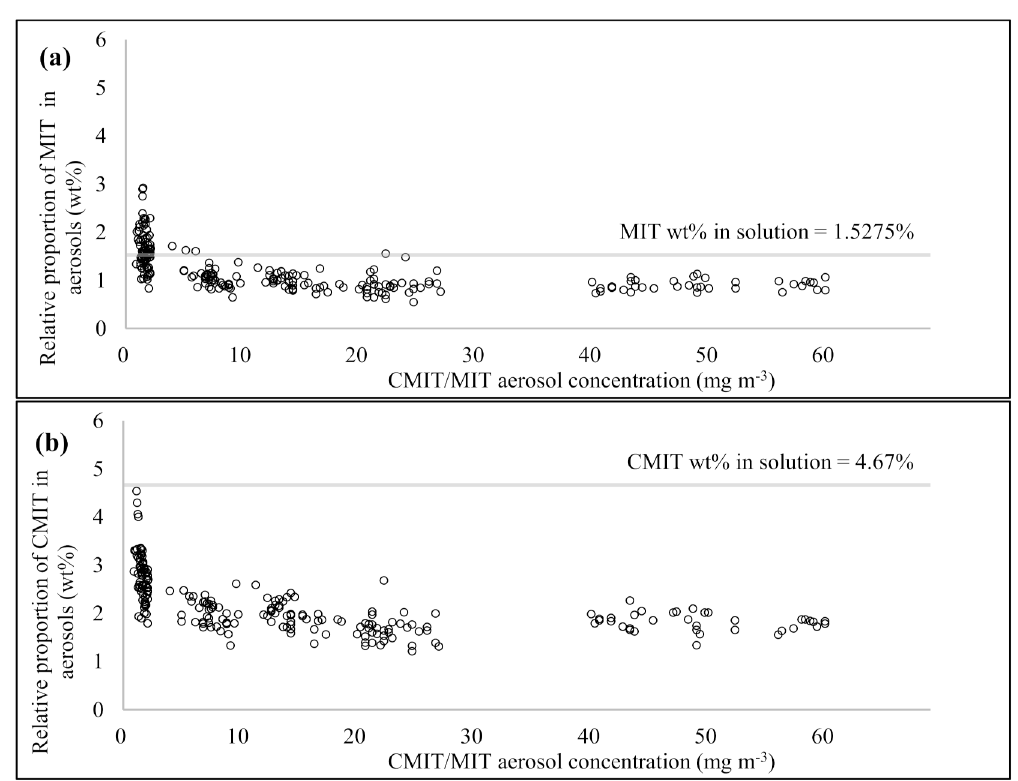
Figure 6. Scatter plot showing relative proportions of MIT and CMIT in CMIT/MIT aerosols with the different aerosol mass concentrations. ( a ) MIT and ( b )